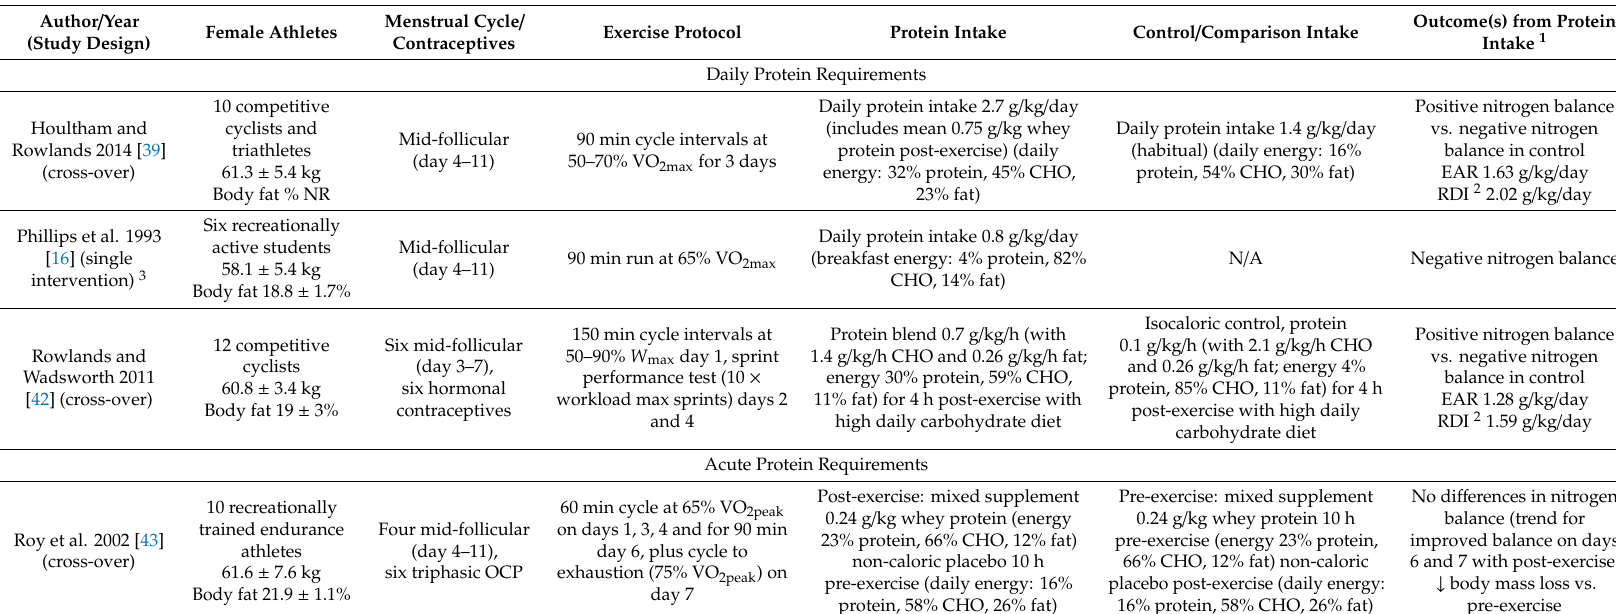
Table 2. Protein requirements of female athletes completing aerobic endurance